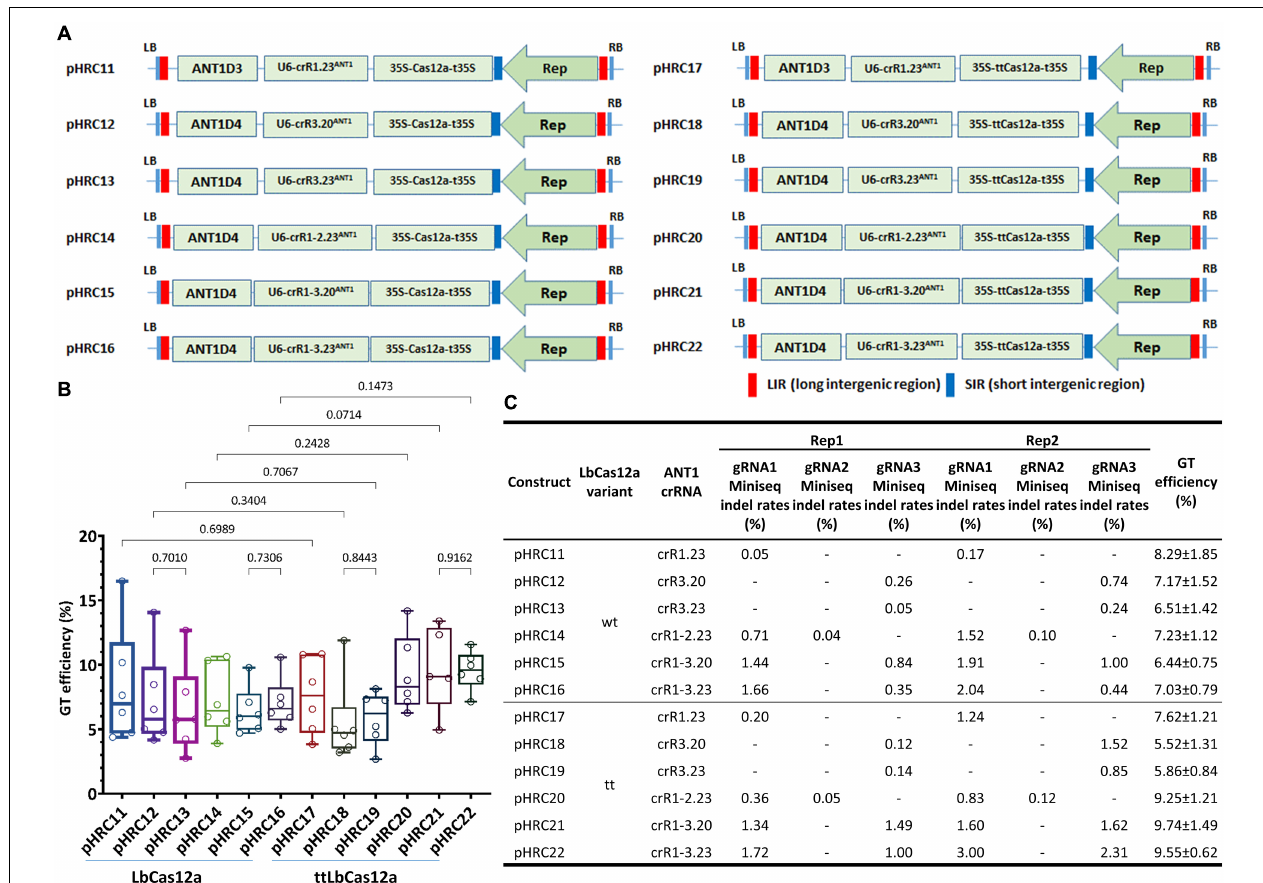
FIGURE 3 | Comparison of GT efficiency between LbCas12a and ttLbCas12a at the SlANT1 locus. (A) Binary constructs with the same crRNAs and donors for the assessment of the GT efficiency of LbCas12a (left panel) and ttLbCas12a (right panel). (B) Boxplot showing the distributions of GT efficiency among the tools using various crRNAs with LbCas12a and ttLbCas12a. Multiple comparisons of the means of GT efficiency of the constructs using the same sets of crRNAs and donors but with LbCas12a or ttLbCas12a were conducted using Fisher’s LSD test, and the p -values are shown above the compared boxes. (C) Indel mutation